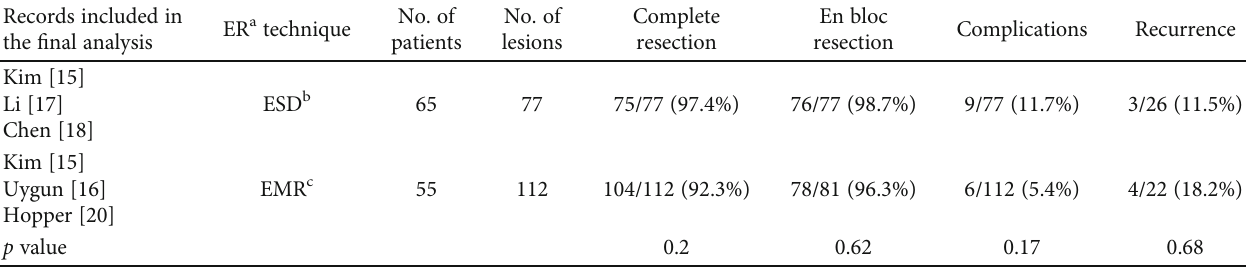
Table 2: Results after pooling data extracted from the selected